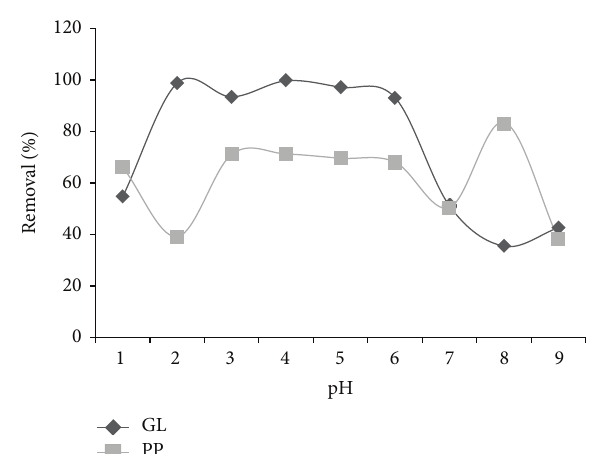
Figure13:Comparativestudyofeffectoftemperatureonpercentage removal of BG.